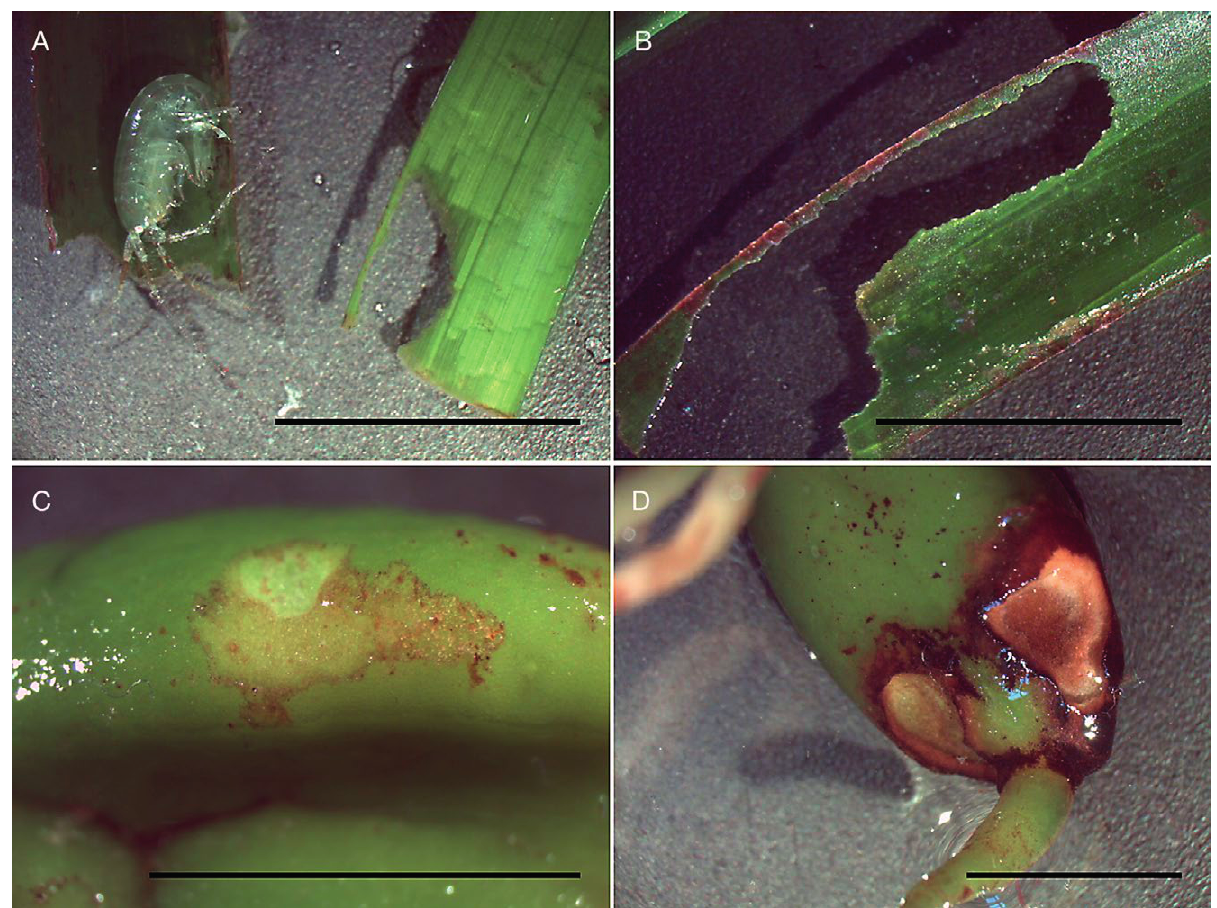
Fig. 1. – Dogtooth bite pattern on leaves and irregular holes on seeds produced by Gammarella fucicola and Ampithoe ramondi. Scale bars show 1.0 cm and 0.5 cm for leaf (A, B) and seed (C, D) photos respectively. A specimen of A. ramondi is also shown in photo